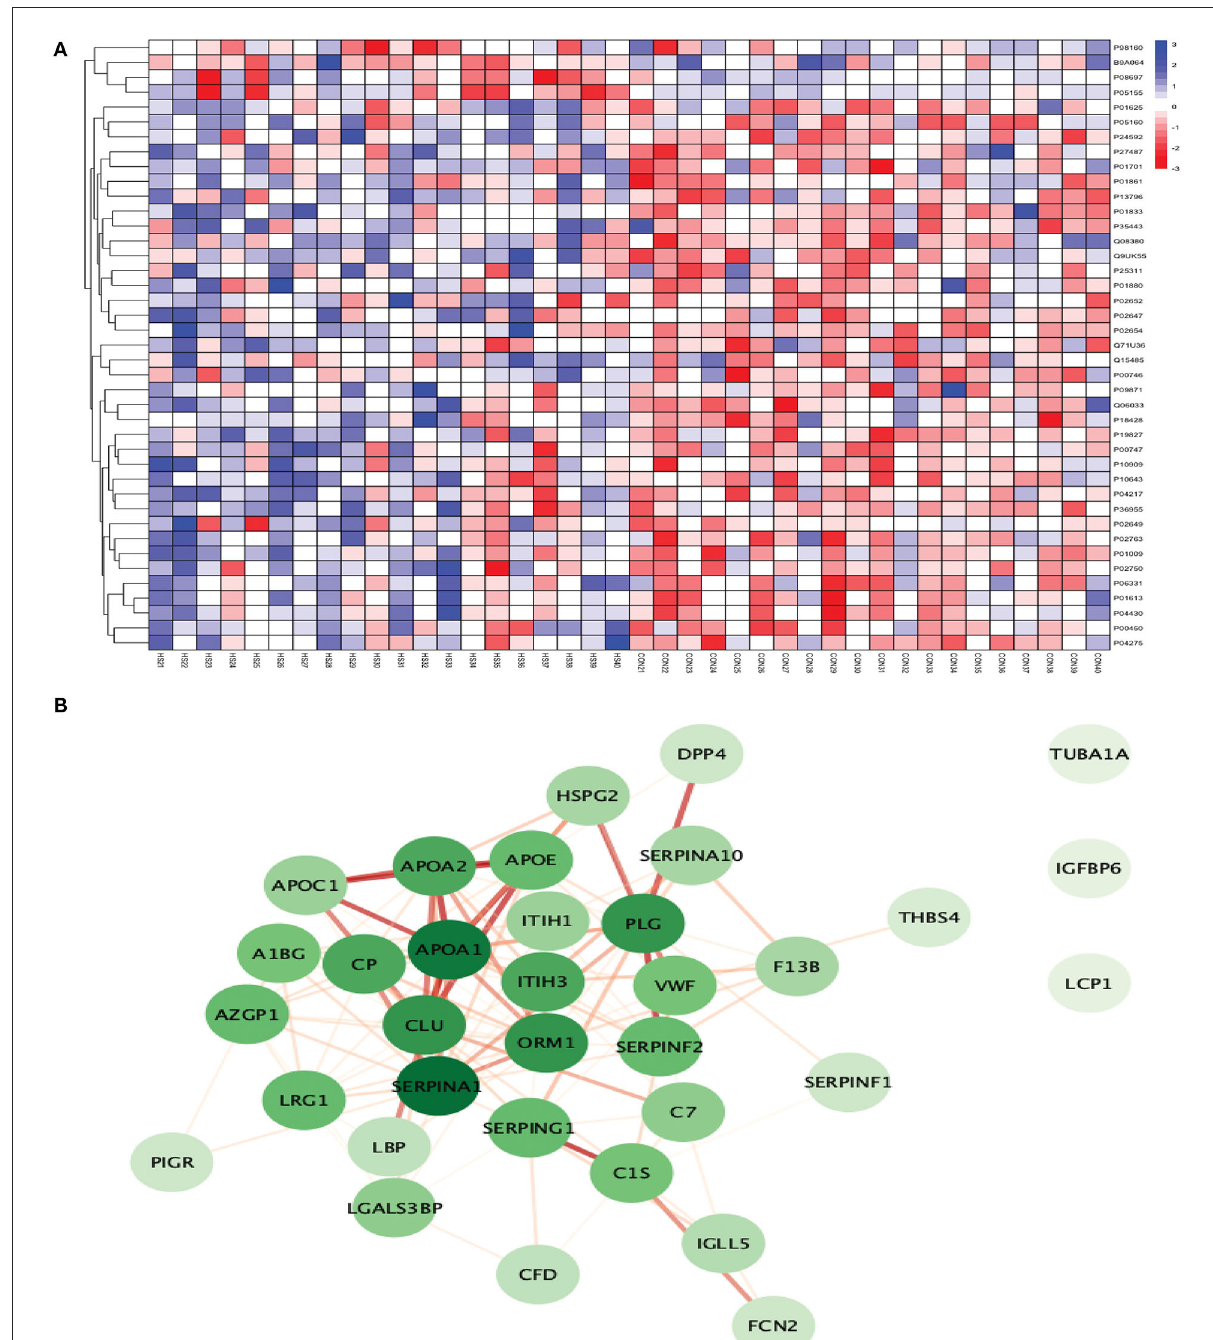
FIGURE9 (A) Heatmap showing the distribution and expression pattern of 41 significantly differentially expressed proteins between ICH and healthy controls. (B) Protein–protein interaction network analysis of differentially expressed proteins between ICH and healthy controls.